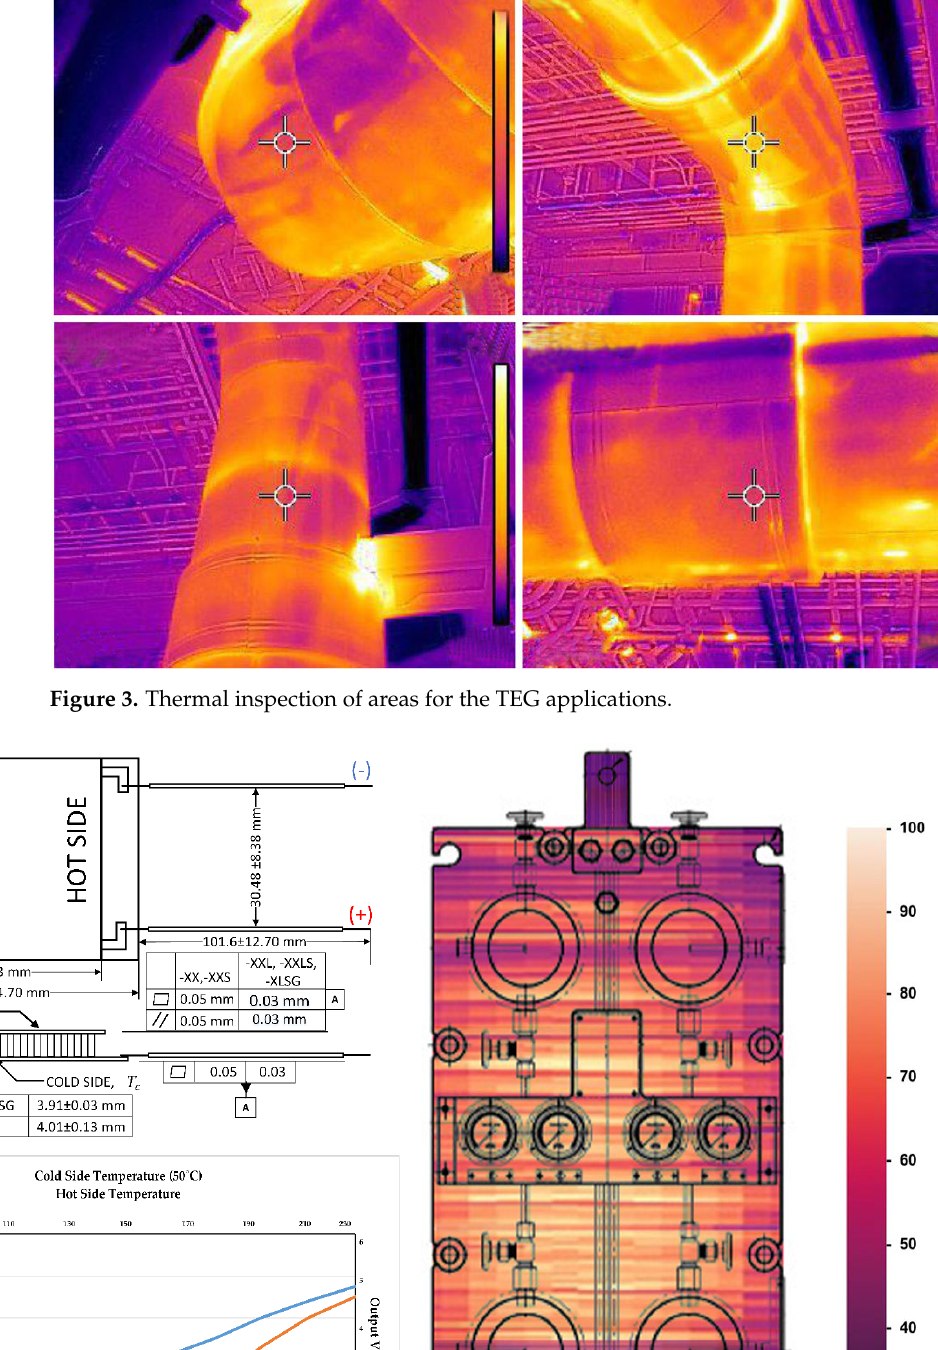
TEGs could produce 4.3–4.1 watts of power per TEG device, respectively, in the other heat layers that formed. Considering Figures 2 and 3 and the application surface areas, the potential power for the main engine exhaust gas pipe is approximately 79,720 watts, and the potential power for the ME JCW heat exchanger surface is nearly 7941.4 watts. With the help of TEGs, it was determined that a total of 87,661 watts of power could be recov- ered in the examined tanker ship. As a result of the analysis, the amount of potential fuel savings that could be realized with the help of TEGs was calculated based on the annual average kW values of the generators. First of all, it was determined that there is a fuel- saving potential of approximately 77.90 tons per year with the help of the power obtained from the TEG system (Figure 2a) when the main engine exhaust gas is active for the cruise condition. When the other TEG system (Figure 2b) was examined, it was determined that its active time per year would be 8765 h, and that the generator fuel consumption value can be reduced by 13.3 tons. When the working hours were examined, it was determined that the fuel-saving values were 25.61 tons of MGO and 65.59 tons of VLSFO. Based on these values, it was found that annual fuel savings values were USD 16,102.62 for MGO and USD 40,206.32 for VLSFO. For the demonstration of the effect of the designed TEG